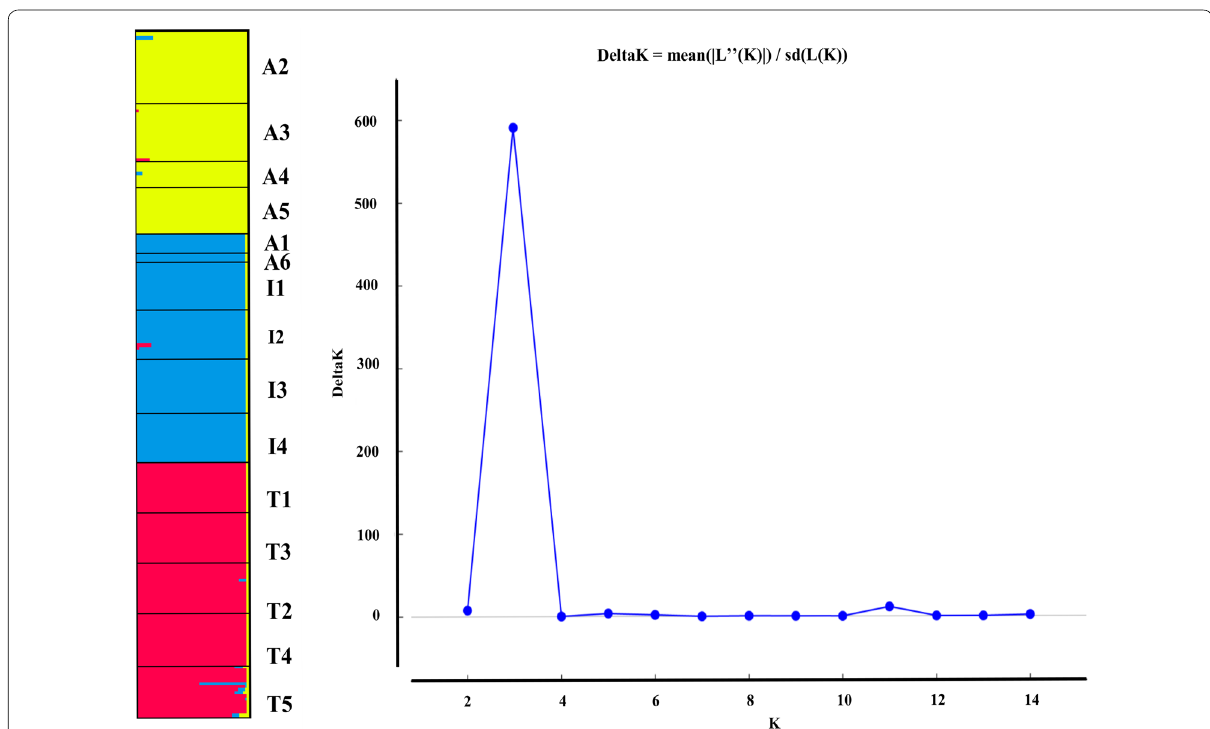
3 (shown on the left); and the plot =